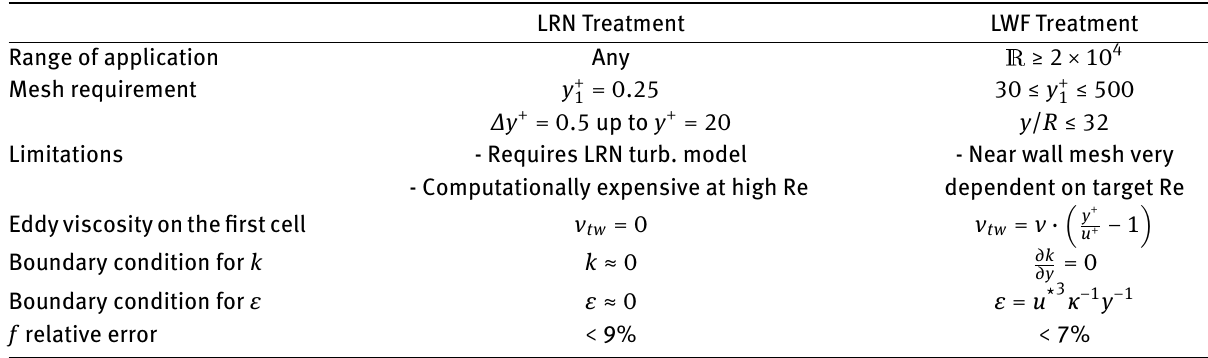
Figure 12: Upper and lower limits of the inertial sublayer (left) and number of grid points in the cross section (right) as a function of the Reynolds number. Table 2: Summary of applicability conditions for the wall